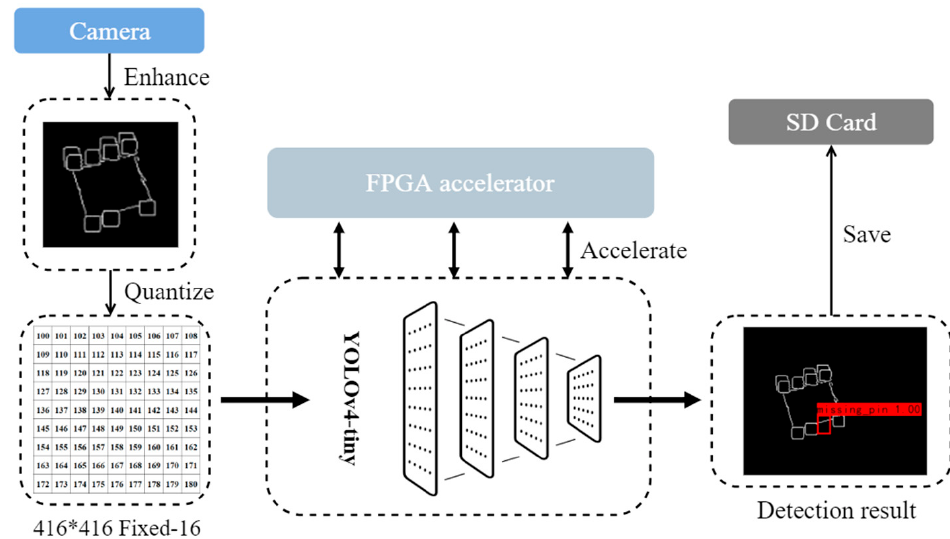
Figure 3. Chip defect detection system workflow.